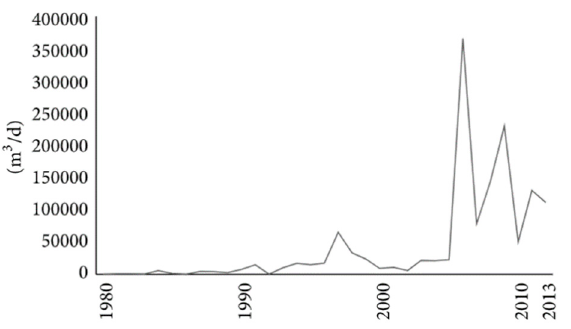
Figure 6. Variations of the capacity of plants for saline water desalination in India